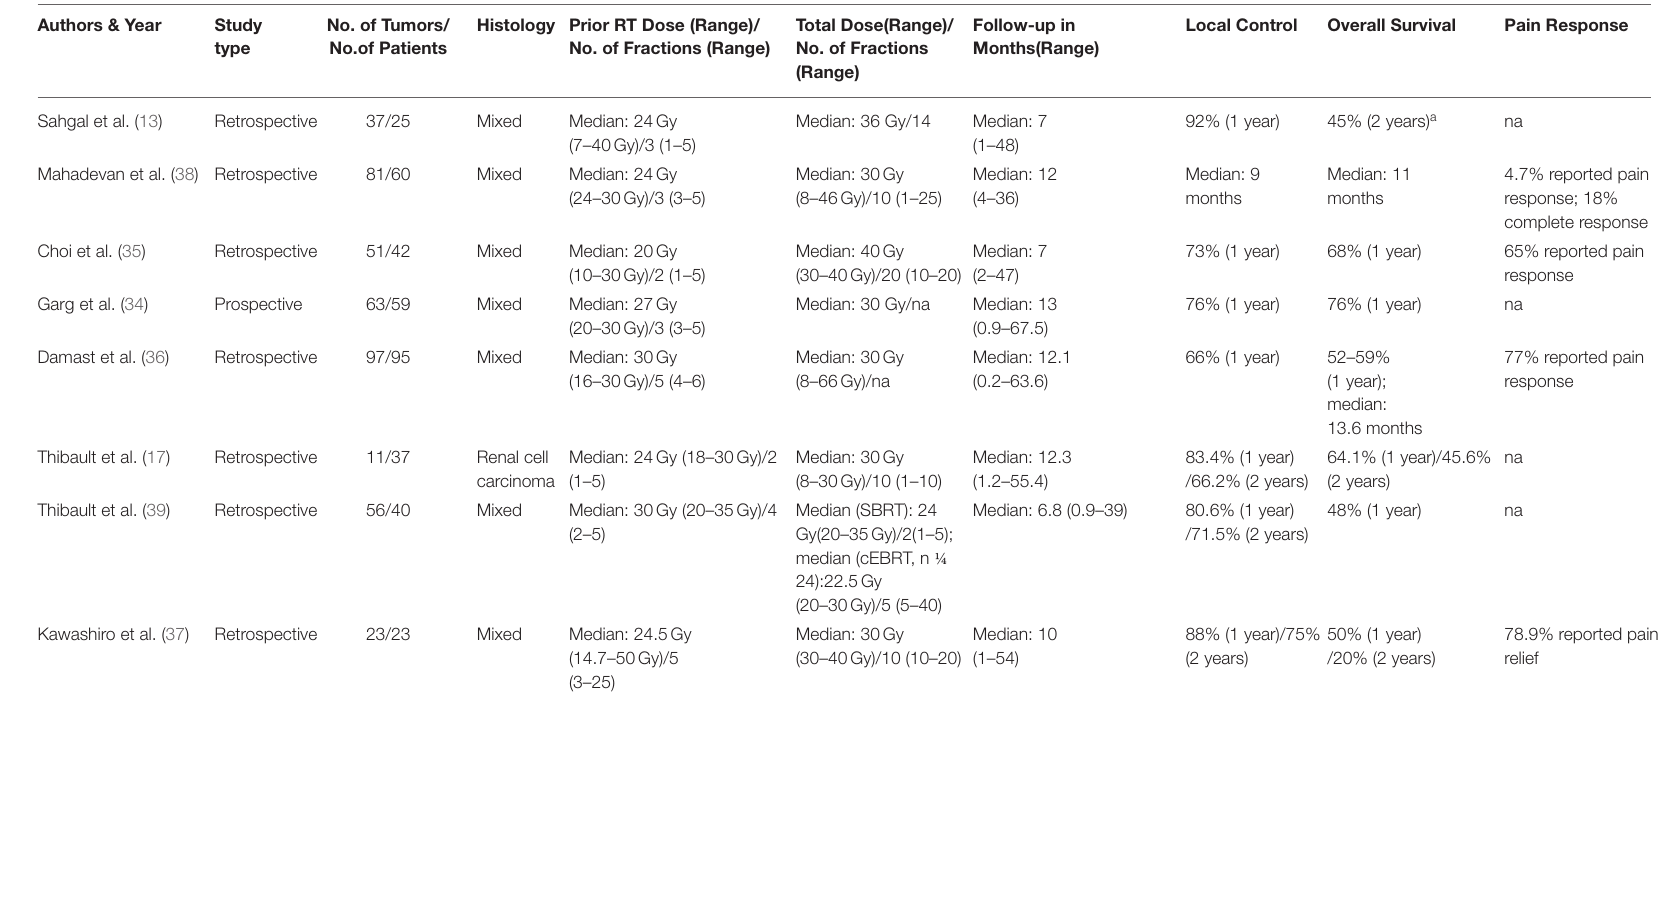
TABLE 2 | Selected re-irradiation spine SABR series for spinal